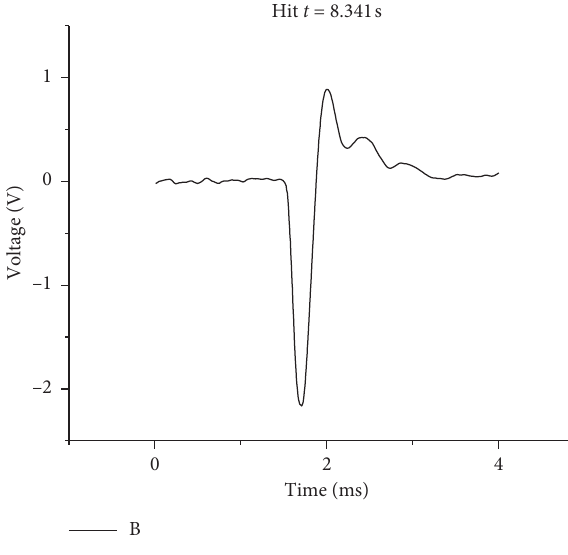
Figure 5: Single hit of